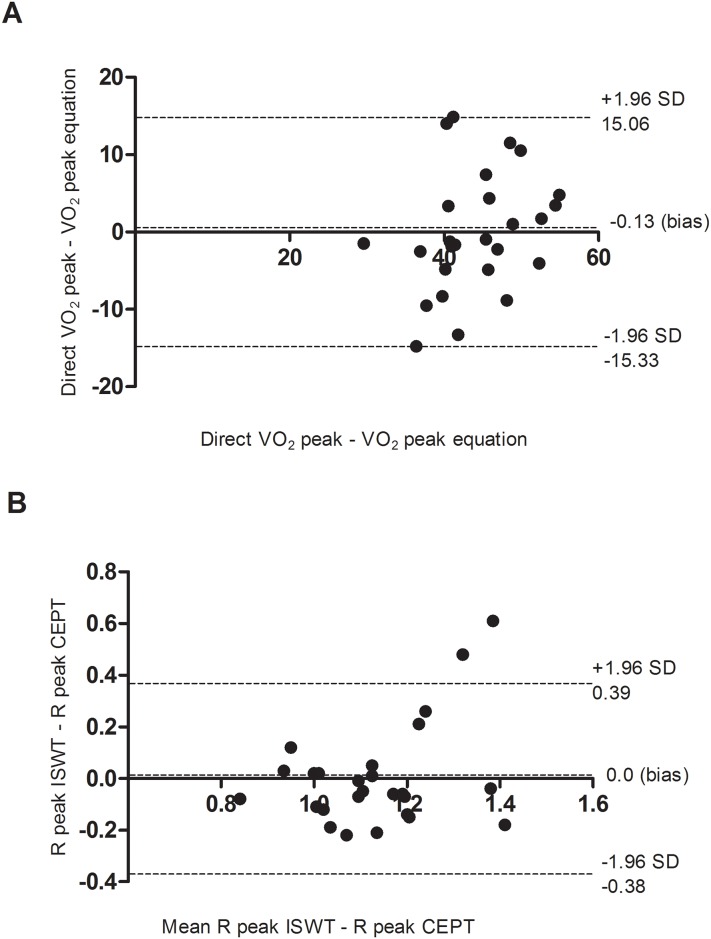
Agreement between VO2 (mL/kg/min) peak and R peak obtained in the ISWT and CEPT.(A) Bland-Altman plot of the difference between the VO2 peak of the ISWT and CEPT plotted against the mean VO2 peak of the ISWT and CEPT; (B) Difference R peak of the ISWT and CEPT plotted against the mean R peak of the ISWT and CEPT. ISWT = Incremental Shuttle Walking Test; CEPT = cardiopulmonary exercise testing; VO2 = oxygen uptake; R = respiratory exchange ratio.